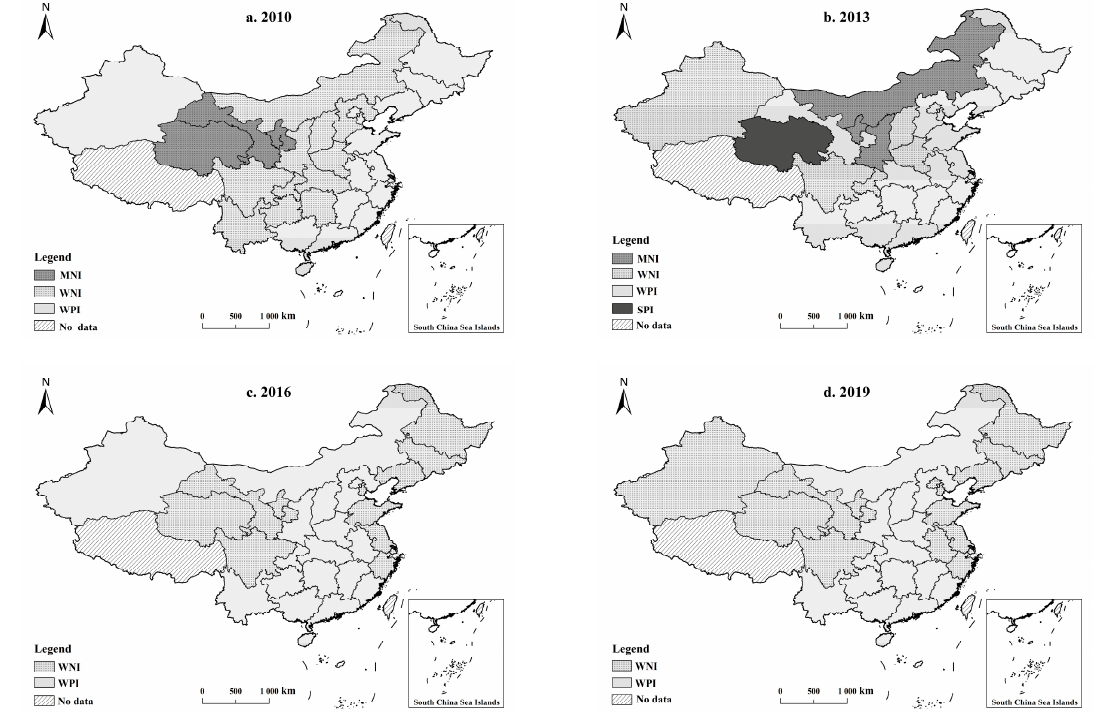
Figure 5. Spatial distribution of the regression coefficients of industrial structure: ( a ) Spatial distribution of the regression coefficients of industrial structure in 2010; ( b ) Spatial distribution of the regression coefficients of industrial structure in 2013; ( c ) Spatial distribution of the regression coefficients of industrial structure in 2016; ( d ) Spatial distribution of the regression coefficients of industrial structure in 2019.